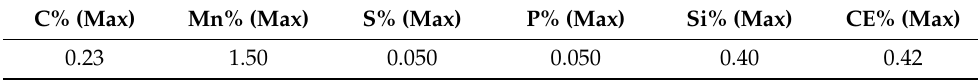
Table 1. Chemical composition of structural steel IS: 2062 Grade A.